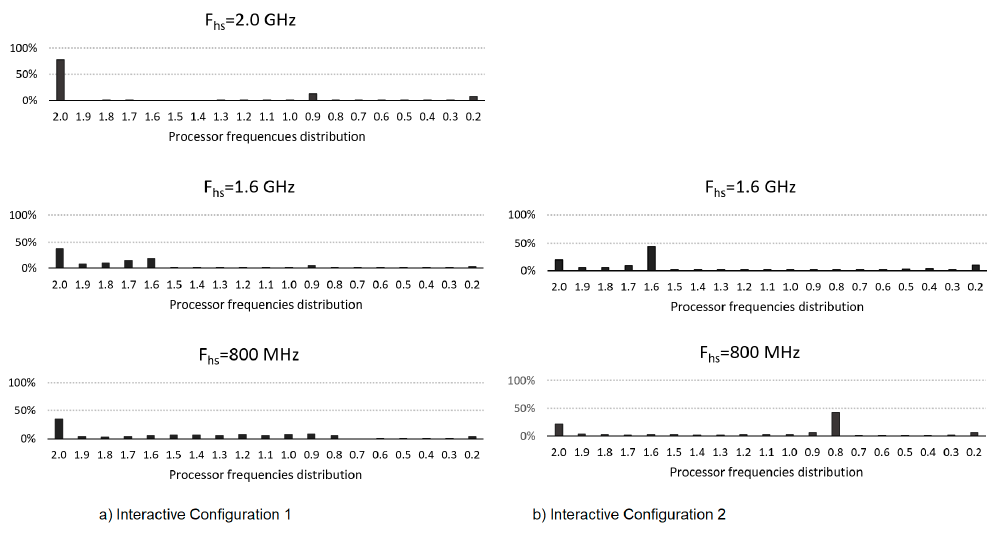
Figure 9. Core frequencies distribution for each configuration for Vid3.